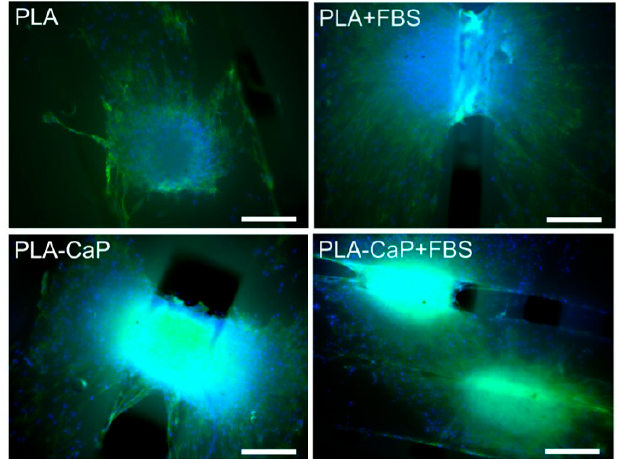
Figure 7. Fluorescence microscopy images of HOb osteospheres cultivated for 7 days over surfaces of PLA, PLA-CaP scaffolds, pre-treated or not with FBS. Cell nuclei appear in blue, and actin microfilaments marked in green. Images obtained either with × 10 objectives. Bars indicate 200 µ m. Total cell and spheroid over each surface were estimated through the detection of LDH, and total protein content after cell permeabilization (Figure 8). While there was no significant difference between uncoated PLA and PLA-CaP scaffolds, it was possible to observe, from both parameters, that PLA-CaP+FBS had a significant ( p < 0.05) presence of cells observed in pure PLA.